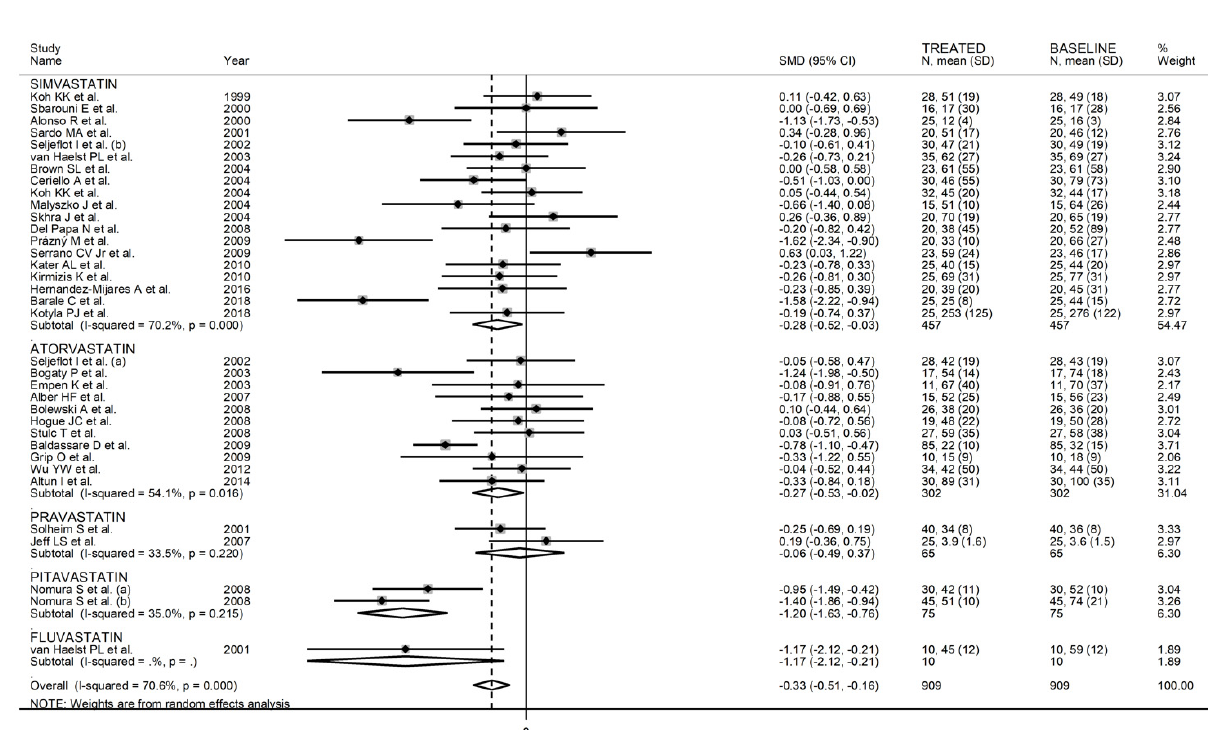
Figure 14. Forest plot of E-Selectin concentrations before and after statin treatment according to statin class (hydrophilic or lipophilic).